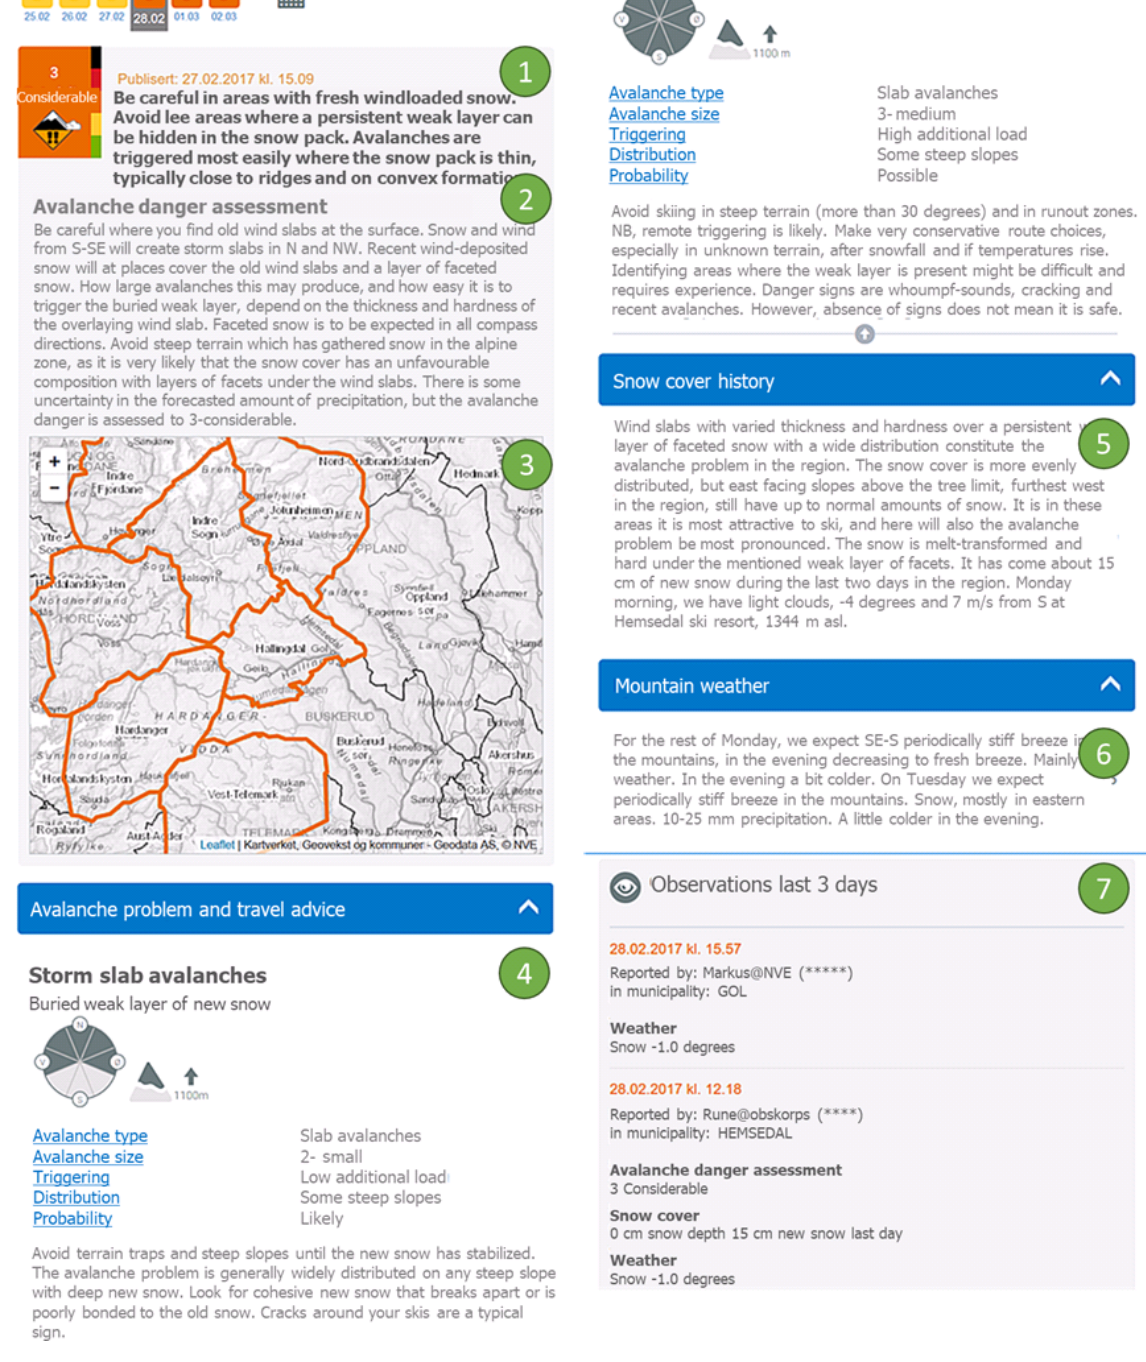
Figure 2. An example of an avalanche warning as issued on Varsom.no in 2017. The numbers refer to the elements analysed in this study. (1) Danger level and main message, (2) avalanche danger assessment, (3) region map, (4) avalanche problems, (5) snow cover history, (6) mountain weather prognosis and (7) RegObs-feed with observations. The figure shows the screen dump from a smartphone, with the middle and right panels showing the screen as the user scrolls down the page. The warning has been translated from Norwegian to English.